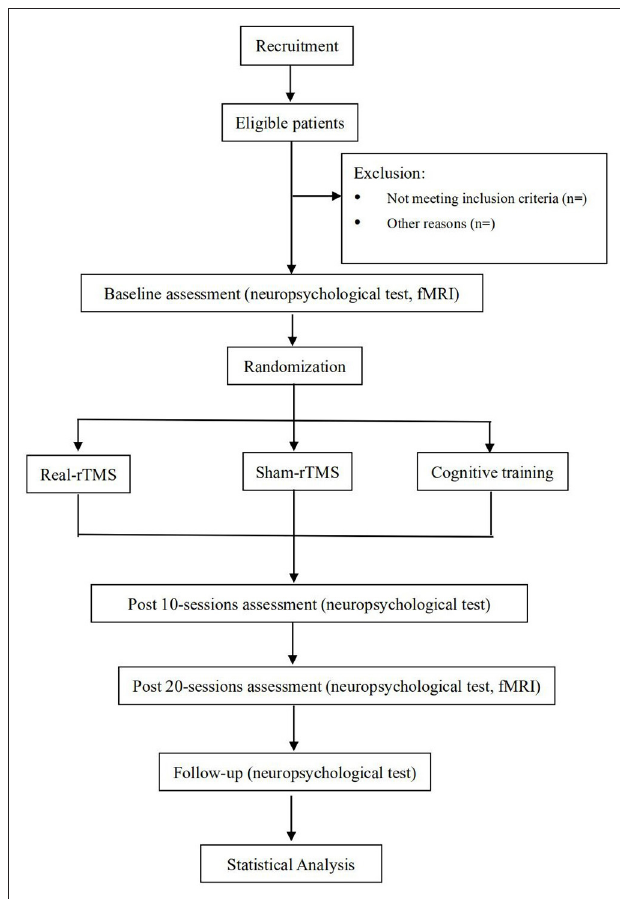
FIGURE 1 | Flowchart of the study design. rTMS, Repetitive Transcranial Magnetic Stimulation; fMRI, functional Magnetic Resonance